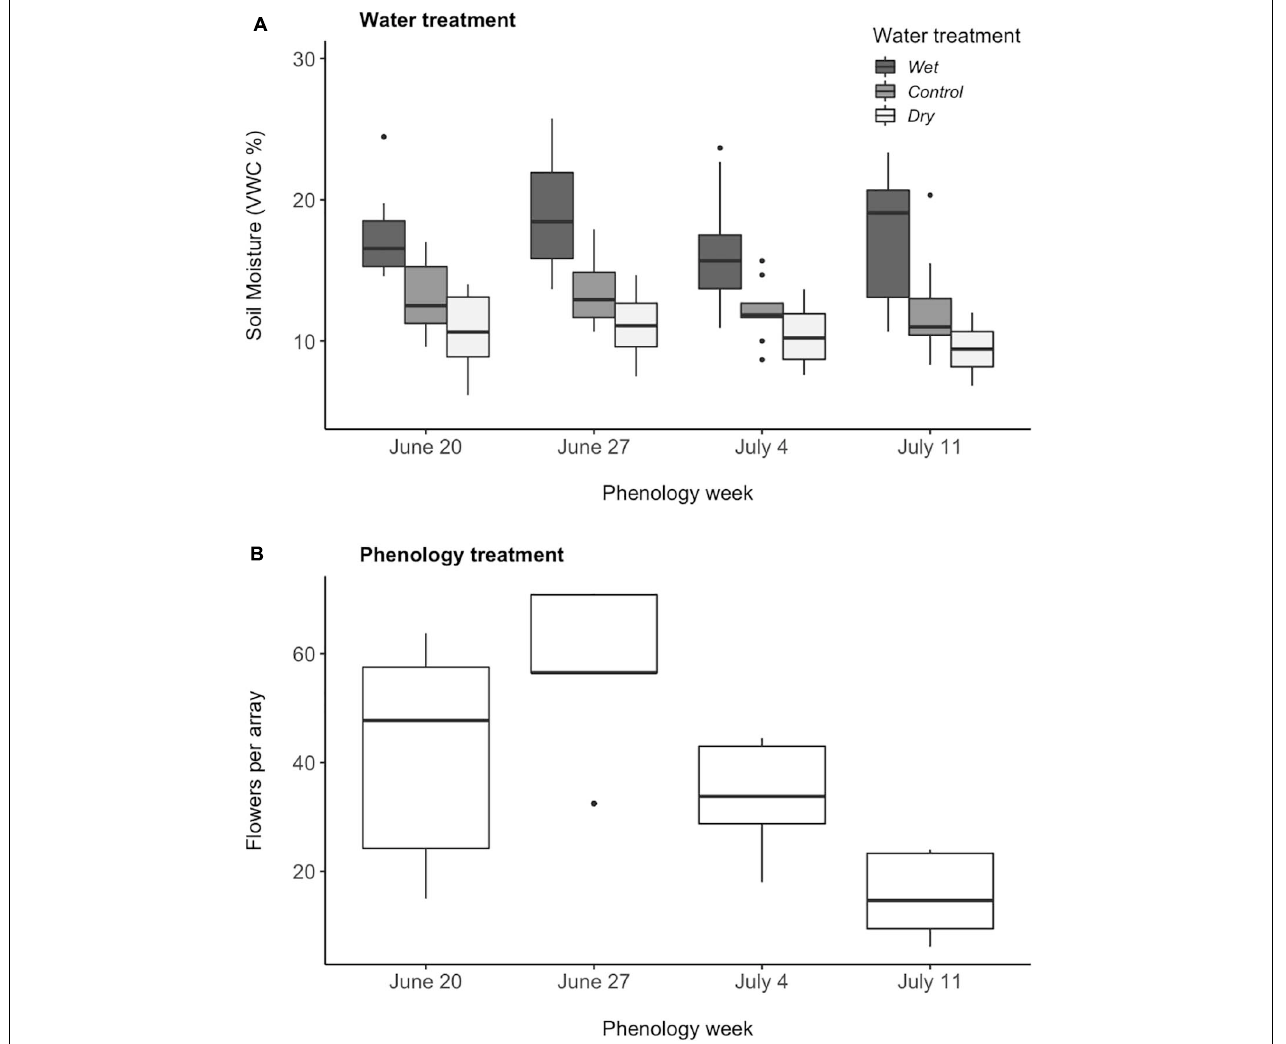
FIGURE 1 | Mean (A) soil moisture of three water treatments and (B) floral abundance per array of Mertensia ciliata plants across four phenology weeks ( N = 114). Soil moisture was measured as volumetric water content (VWC), assessed every third day, and when applicable, always before applying water. The center of the boxplot represents the median value, the edges of the box indicate the 25th and 75th percentiles, the whiskers represent the 5th and 95th percentiles of the distributions, and the points indicate outlaying